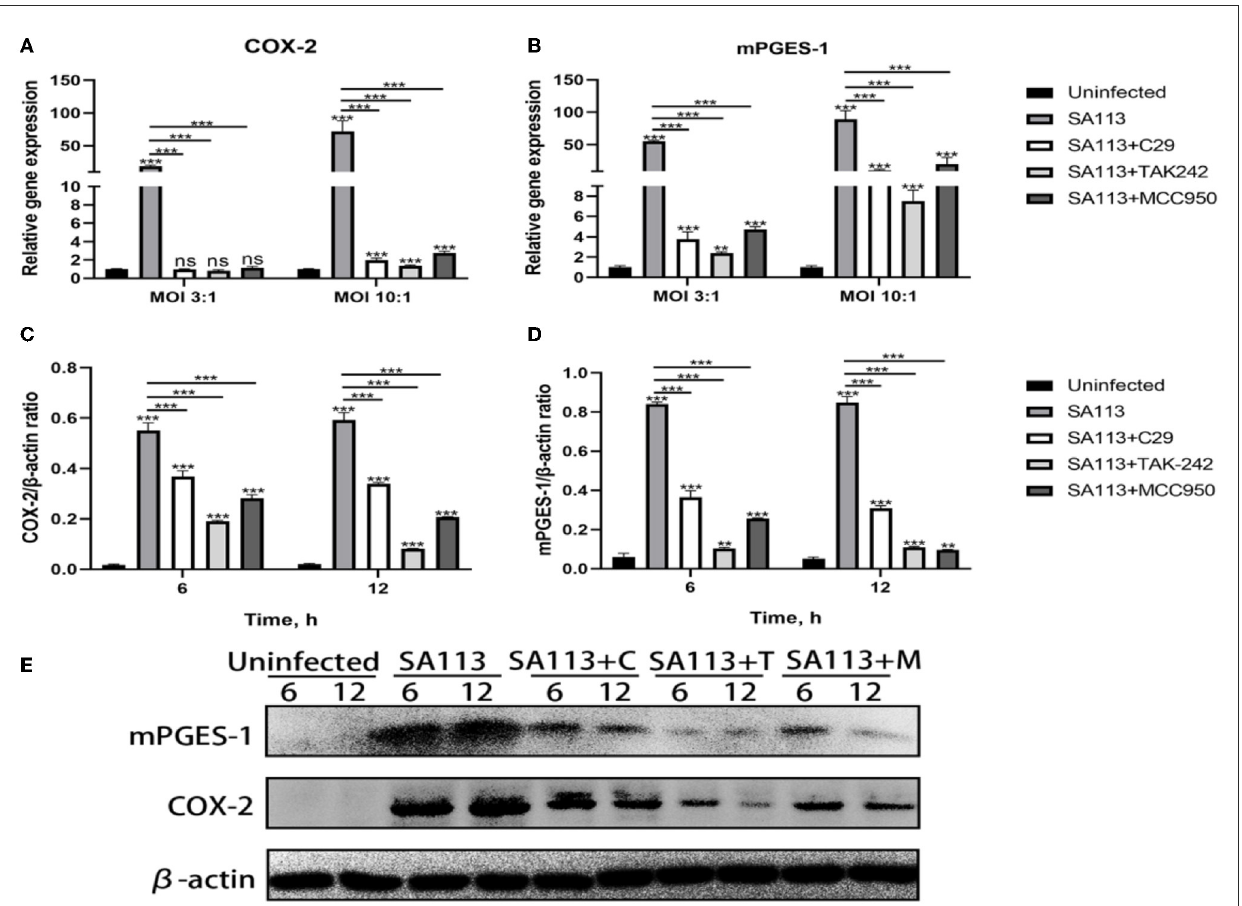
FIGURE4 TLR2, TLR4, and NLRP3 affect COX-2 and mPGES-1 expressions in neutrophils after S. aureus infection. qRT-PCR results showed that C29, TAK-242, and MCC950 inhibitors at 8h affected the expression of COX-2 and mPGES-1 in MOI 3:1 and MOI 10:1 (A, B) . Western blot results showed that C29, TAK-242, and MCC950 inhibitors at 6h and 12h affected the expression of COX-2 and mPGES-1 in MOI 10:1 (C–E) . ns P > 0.05, * P < 0.05; ** P < 0.01; *** P <